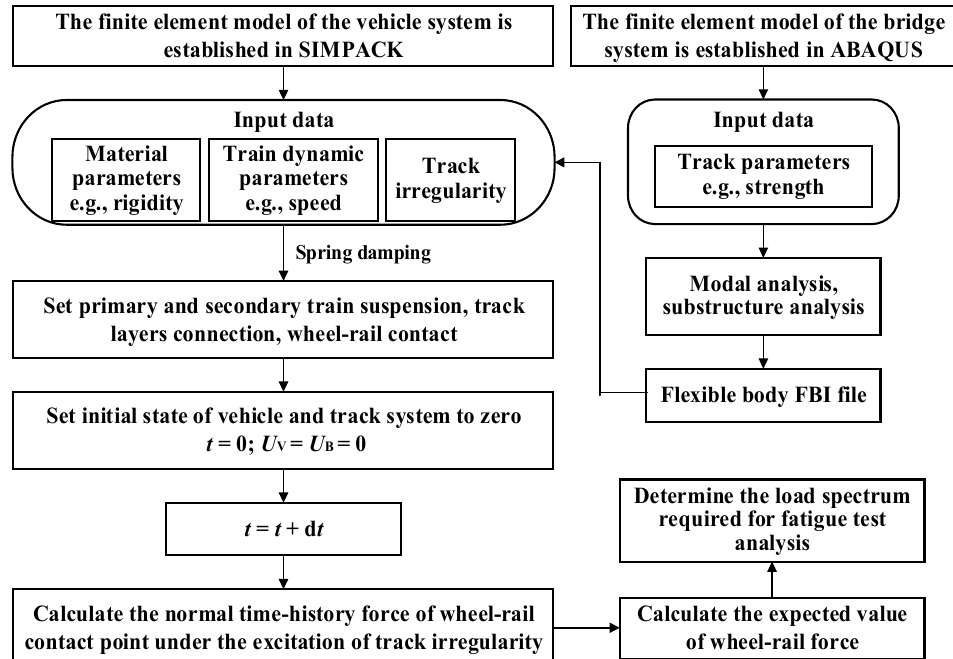
Figure 16. Fatigue load analysis based on vehicle-rail-bridge coupling vibration.